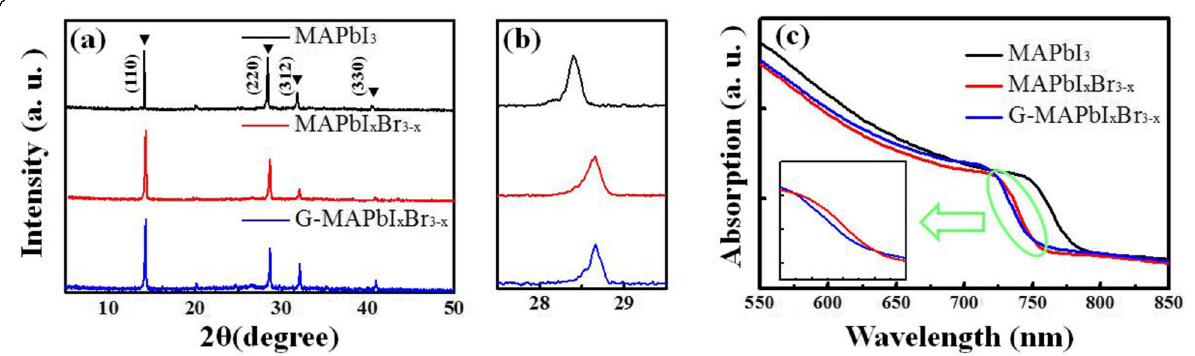
Fig. 3 a XRD patterns of perovskite films, b their partial enlargement, and c absorption spectra